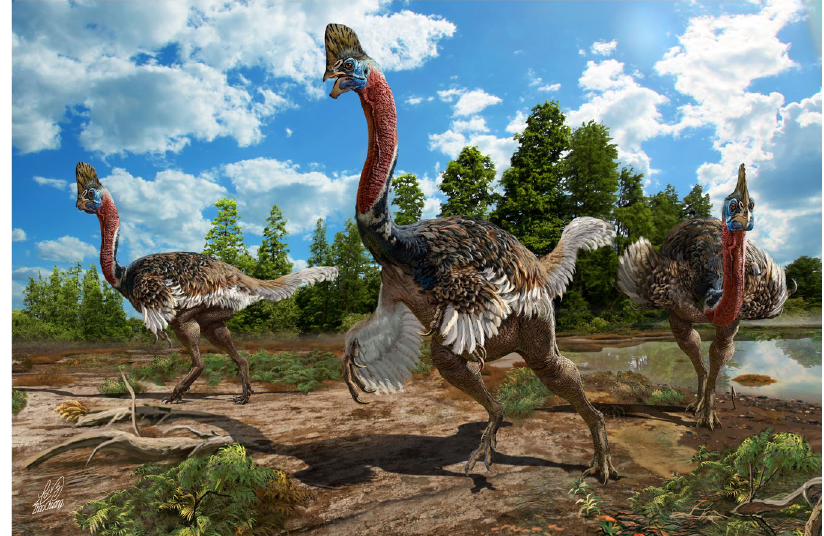
Figure 5. The living scene of Corythoraptor jacobsi gen. et sp. nov. (Drawn by Zhao